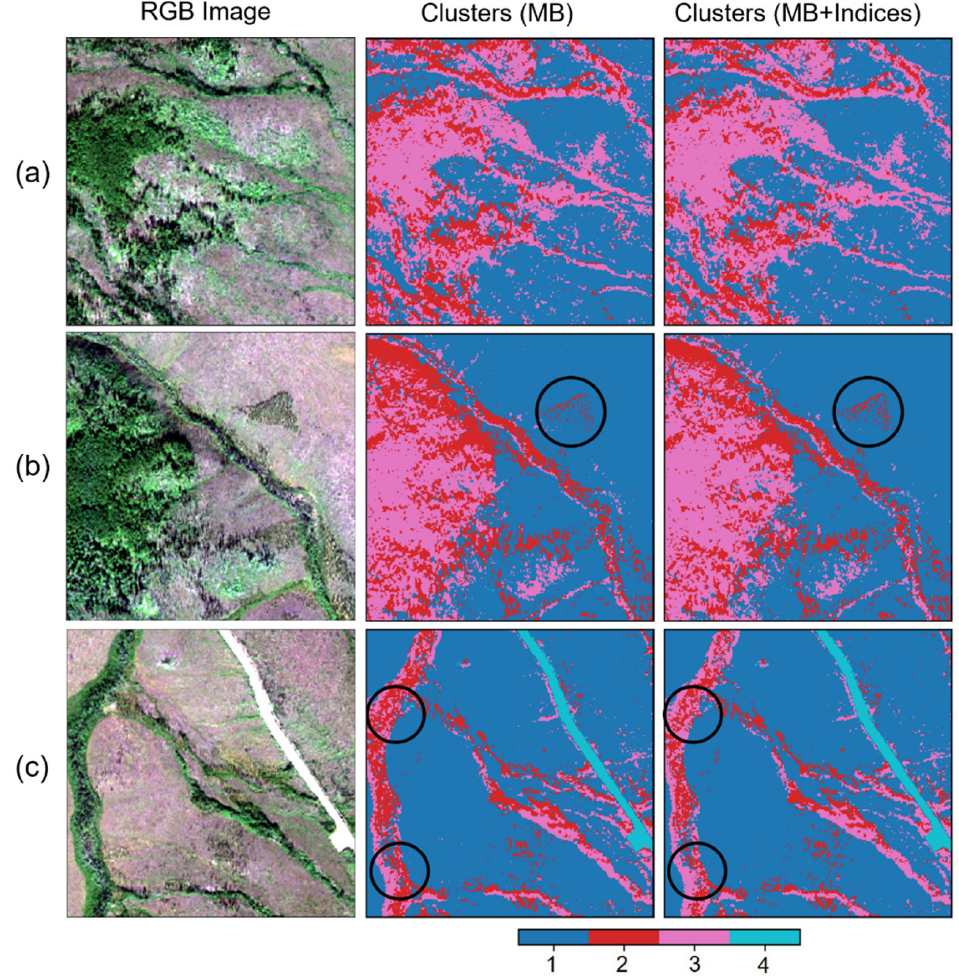
Figure A1. GMM clustering results by inputting different features, ( a – c ) correspond to Site-1, Site-2, and Site-3, respectively. The areas outlined by circles are highlighted for comparison. Here, MB stands for the WV-2 multispectral bands. Indices refer to the additionally included vegetation (NDVI, MSAVI) and water indices (NDWI) (Section 2.2.1).